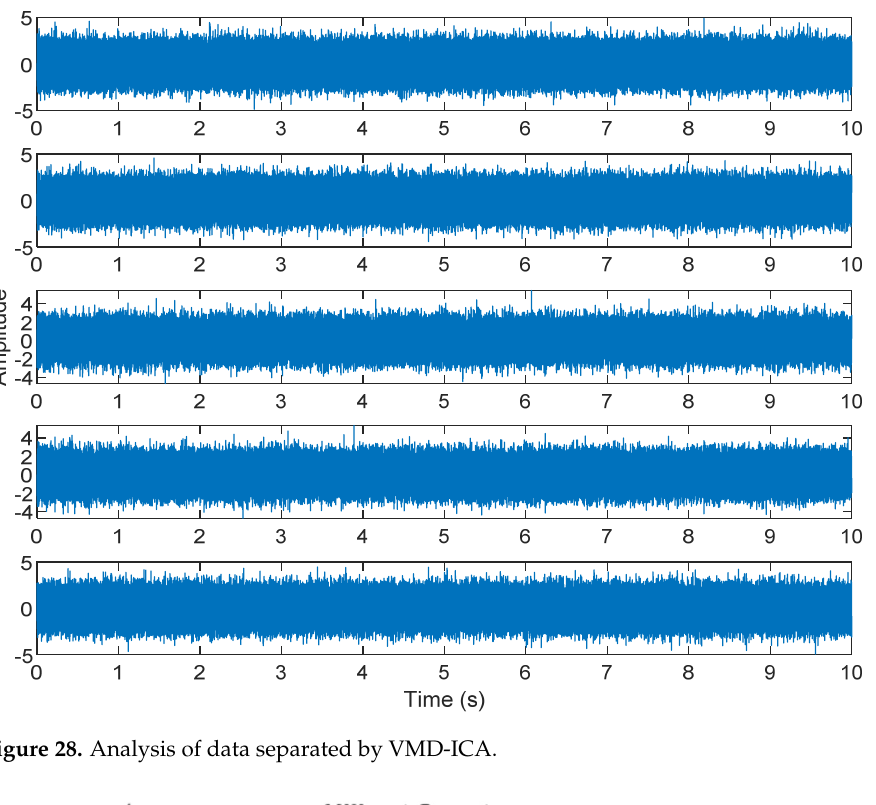
Figure 28. Analysis of data separated by VMD-ICA.